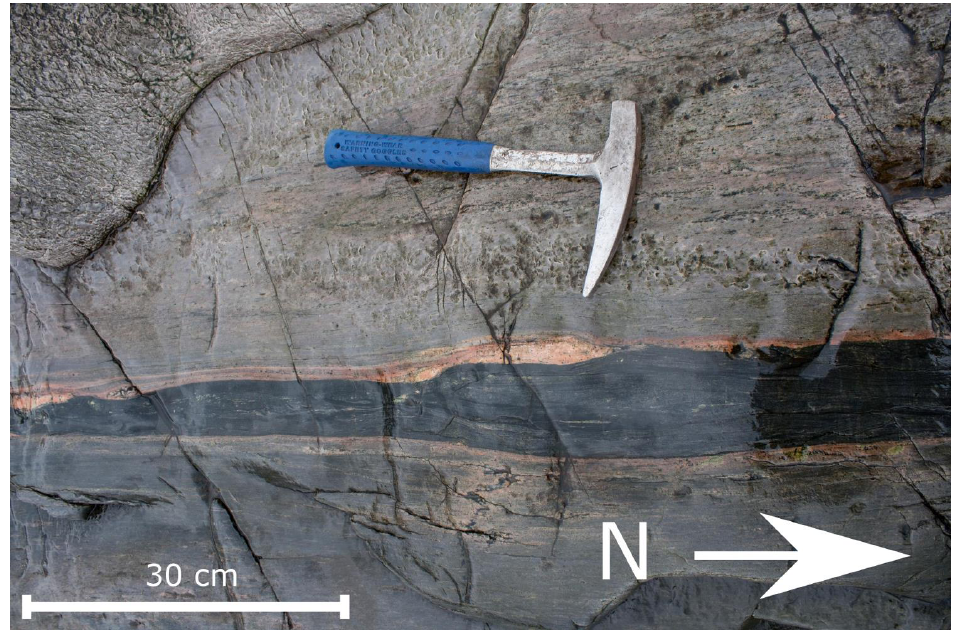
Figure 4. An example of the metamorphic fabric observed in the basement units on Big Island, ~2 km northwest of Makkovik. Viewing angle is looking down on the exposure with north to the right.